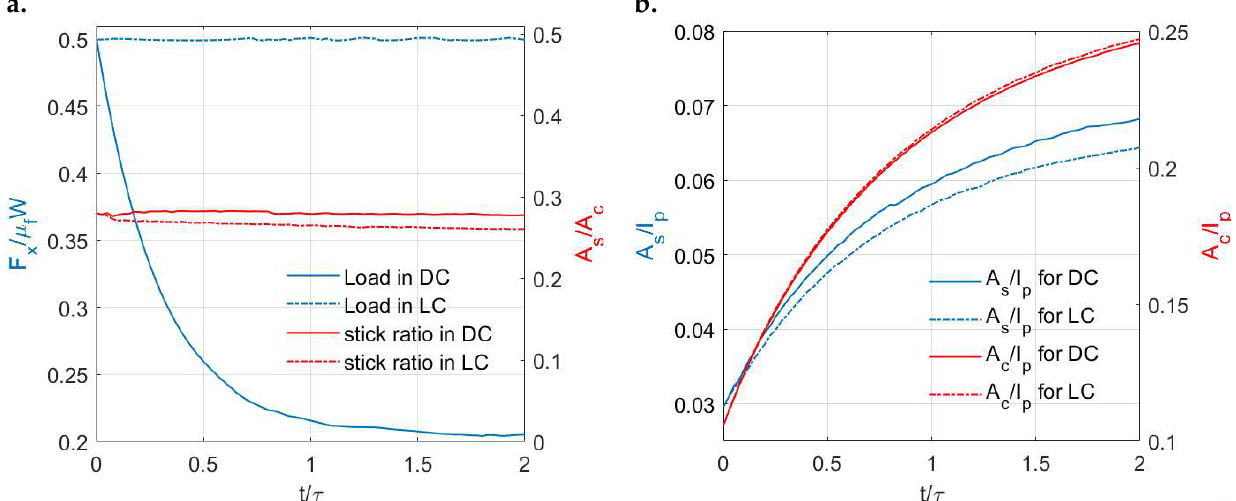
Figure 16. Simulation solutions of viscoelastic partial slip contact under different input conditions: ( a ) Variations in the tangential loads ( y axis left) and stick ratios ( y axis right) with time in the DC and LC cases and ( b ) Variations in the ratio of the stick region to the simulation domain ( y axis left) and the ratio of the contacting area to the simulation domain with time ( y axis right) in the DC and LC cases.